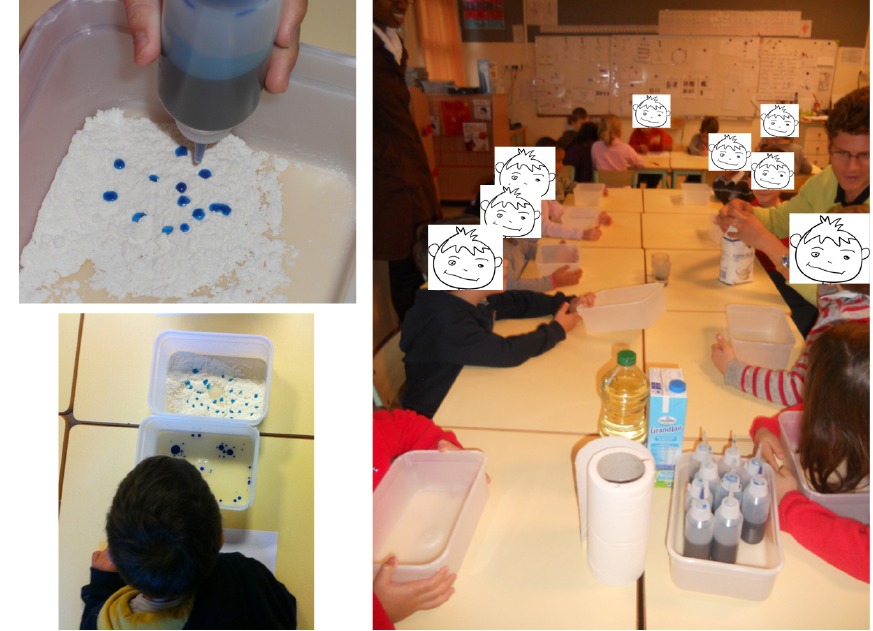
Figure 2. Designing and testing disdrometers (either with oil or flour) in a classroom with artificial drops of tinted water.